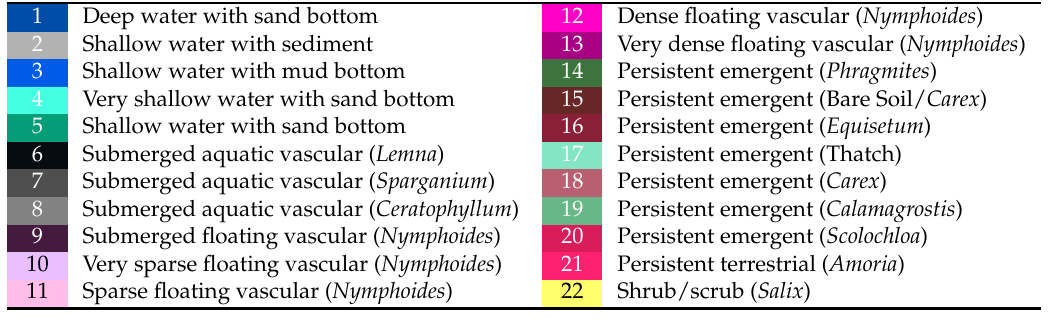
Table 1. Description of wetland classes and aquatic habitats from ISODATA unsupervised classifier and subsequently informed by field-based sampling. The habitat data parenthetically noted represents botanical characteristics of the wetland classes with adequate specificity and fidelity to be considered class indicators (see [17] for additional information).